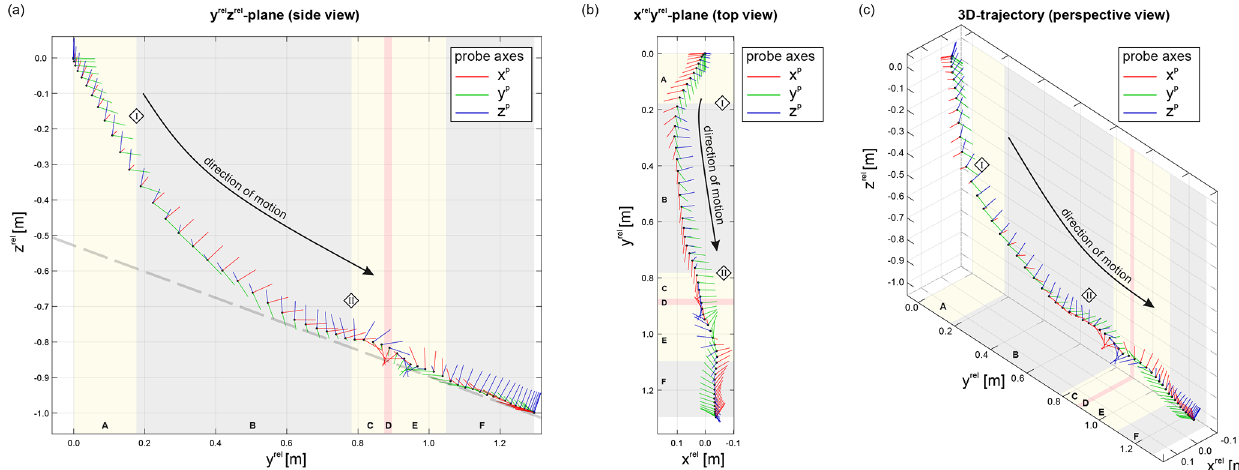
Figure 5. Visualization of the reconstructed trajectory within the relative reference system. Red, green and blue coloured lines indicate probe axes and display its orientation within the relative reference system as defined in Sect. 2.2. Motion phases and distinct time points are indicated as in Fig. 3. (a) 2D side view ( y rel z rel plane), (b) 2D top view ( x rel y rel plane) and (c) 3D perspective view. The dashed grey line represents the tilted flume for